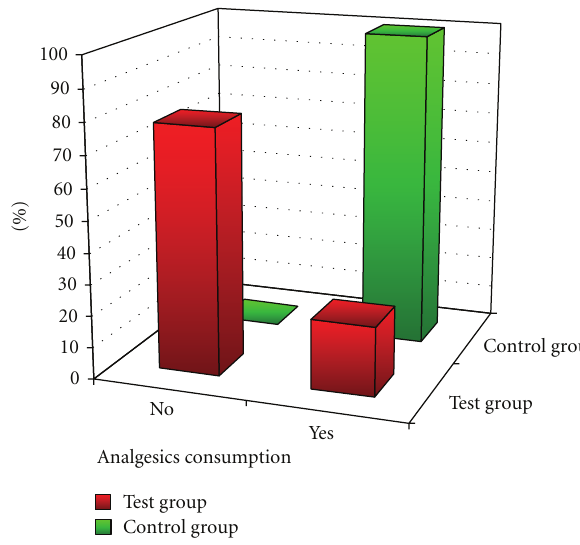
Figure 5: Comparison of pain relief medicines (in %) for patients in both